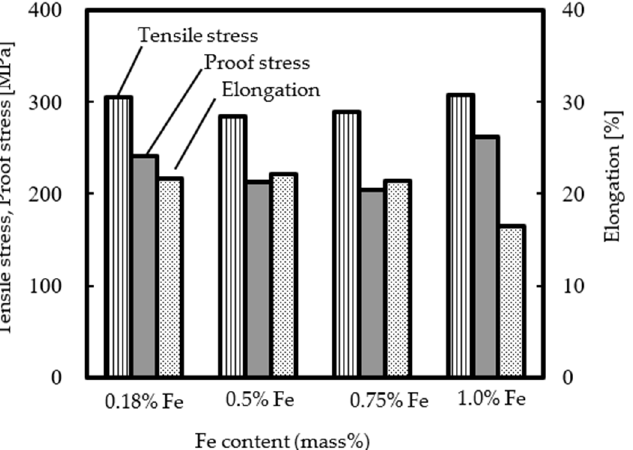
Figure 14. Effects of Fe content on the results of a tension test. Cold-rolled and annealed 1-mm-thick strip was used for the tension test. The gage length was 50 mm. Aluminum alloy: 6016 and Fe added 6016, Roll speed 60 m/min, Roll diameter: 300 mm, Roll width: 100 mm, Roll load: 0.14 kN/mm, Solidification length: 100 mm.